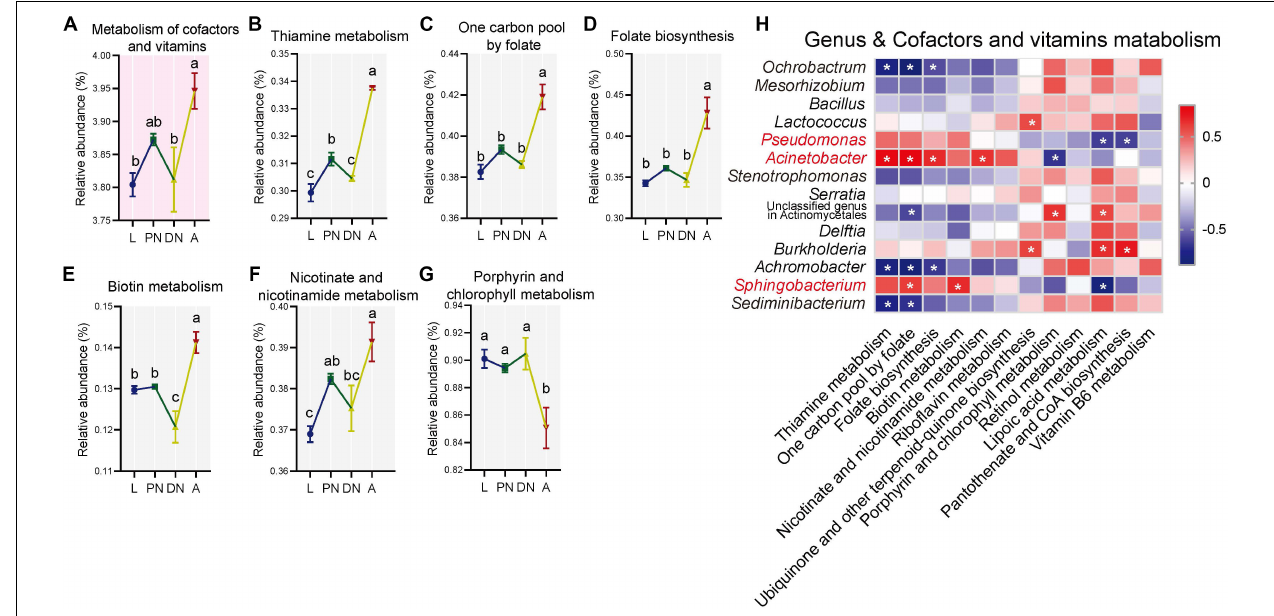
FIGURE 6 | Dynamics of predicted KEGG pathways of “metabolism of cofactors and vitamins” and sublevel pathways across the lifespan of P. citri . (A–G) The “metabolism of cofactors and vitamins” pathway at level two (A) and five sublevel pathways at level three (B–G) significantly varied across the larva (L), protonymph (PN), deutonymph (DN), and adult (A) stages; all n = 3; different lowercase letters denote significant differences between different life stages ( P < 0.05, post hoc DMRT); plots showed means ± SEM. (H) Heatmaps based on Spearman’s correlation analysis between the relative abundances of “metabolism of cofactors and vitamins” pathways and major genera; the red and blue represent positive and negative correlations between the relative abundances of pathways and bacterial genera, respectively; *indicated P < 0.05, Student’s t